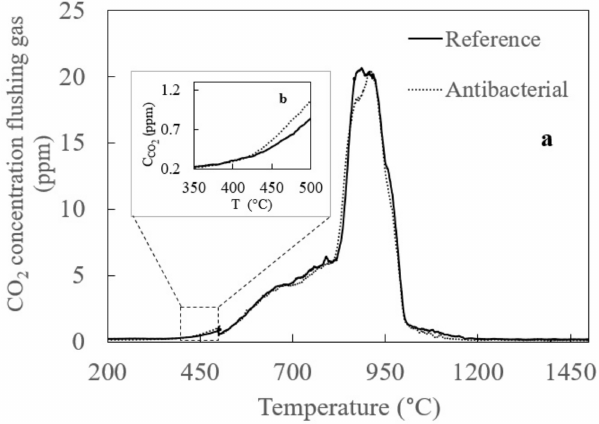
Figure 6. ( a ) CO 2 release during HTMOS measurements and ( b ) CO 2 release at the start of melting